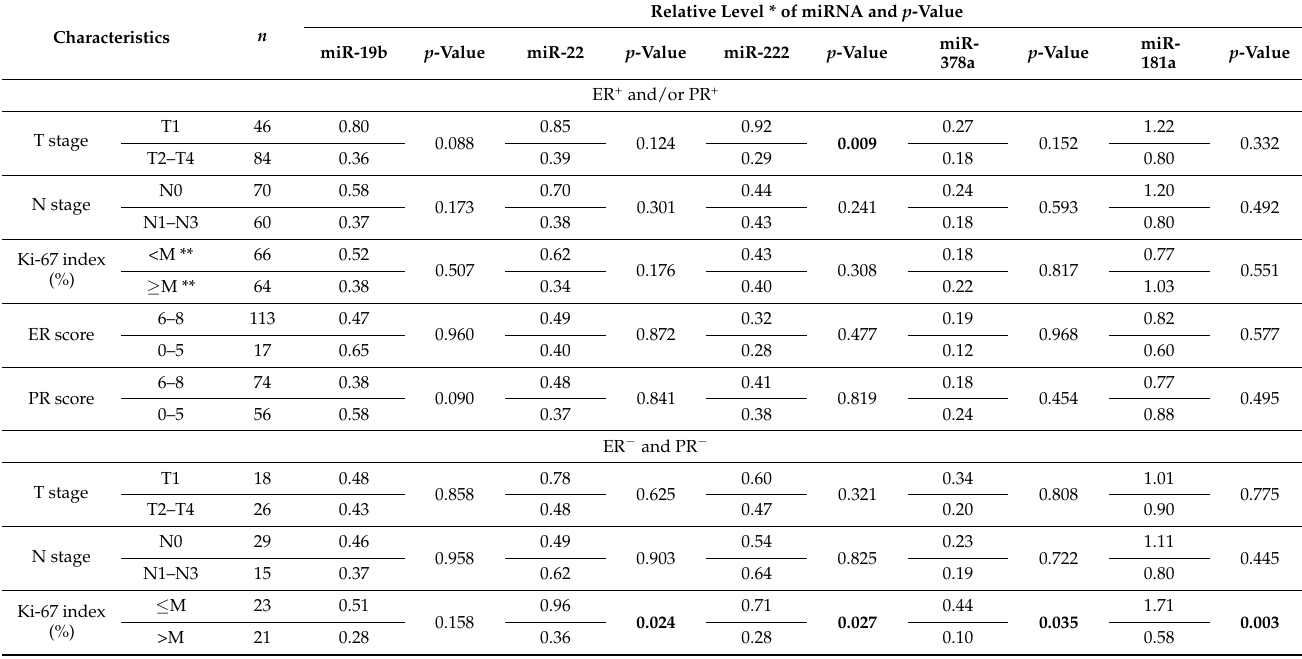
* Median of relative differences in miRNA amounts between breast tumors and paired samples of normal adjoining (control) tissue; the results were normalized to the control. ** M—median value. For ER − and/or PR-positive BC, median = 12, and for ER-and-PR-negative cancer, median = 35. Significant differences are highlighted in